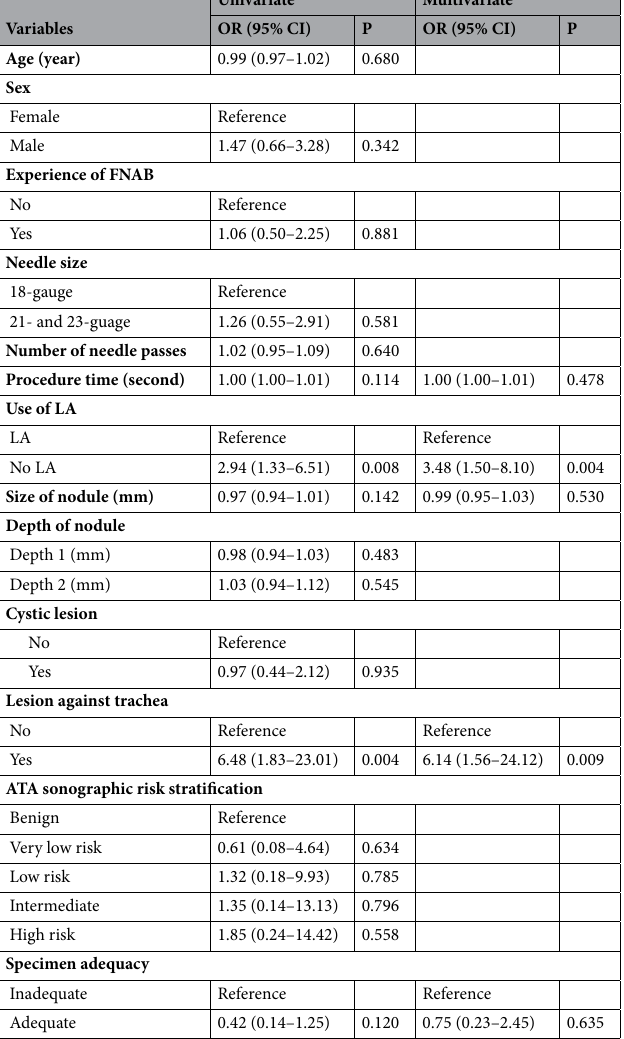
Table 4. Ordinal logistic regression for the associated factors of degree of immediate pain after FNAB. FNAB, fine-needle aspiration biopsy; LA, local anesthesia; ATA, American Thyroid Association; NA, not available; OR, odds ratio; CI, confidence